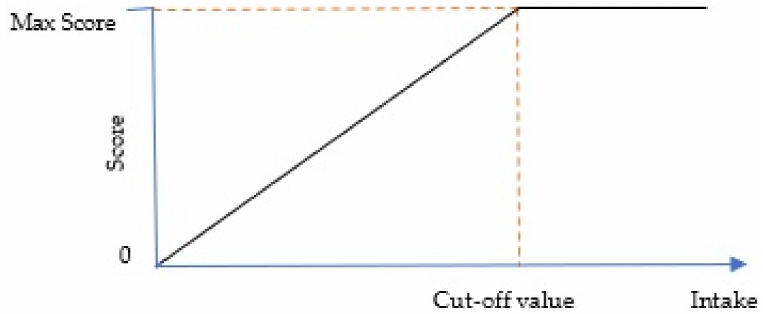
Figure 1. Relationship between score and adequacy component intake. The cut-off value for adequacy components is the lowest recommended amount ‘per 1000 kcal’ for daily energy intake between 1200 to 3000 kcal. When an energy density approach was applied, the amount appeared to be quite similar across energy levels (Table 2) and not increasing linearly as when they were not expressed in ‘per 1000 kcal’ unit. Thus, by applying the least restrictive method in determining the cut-off value, the value chosen still meets the needs of people who have higher energy requirements since the higher calorie patterns had the same nutrient goals [2]. For example, in Table 2, the lowest recommended amount of total grains for daily energy intake between 1200 to 3000 kcal grains is 1.4 servings per 1000 kcal. This means that for someone who needs 2500 kcal, he must consume at least (2500 kcal × 1.4 servings/1000 kcal) 3.5 servings daily to get the maximum score while someone who needs 3000 kcal must consume at least